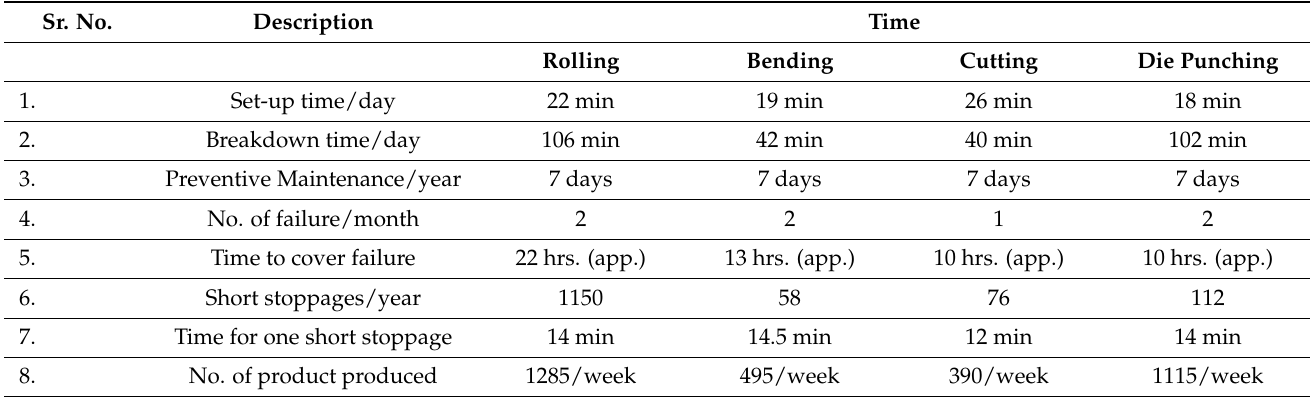
Table 3. Data used for OEE evaluation (after TPM implementation).